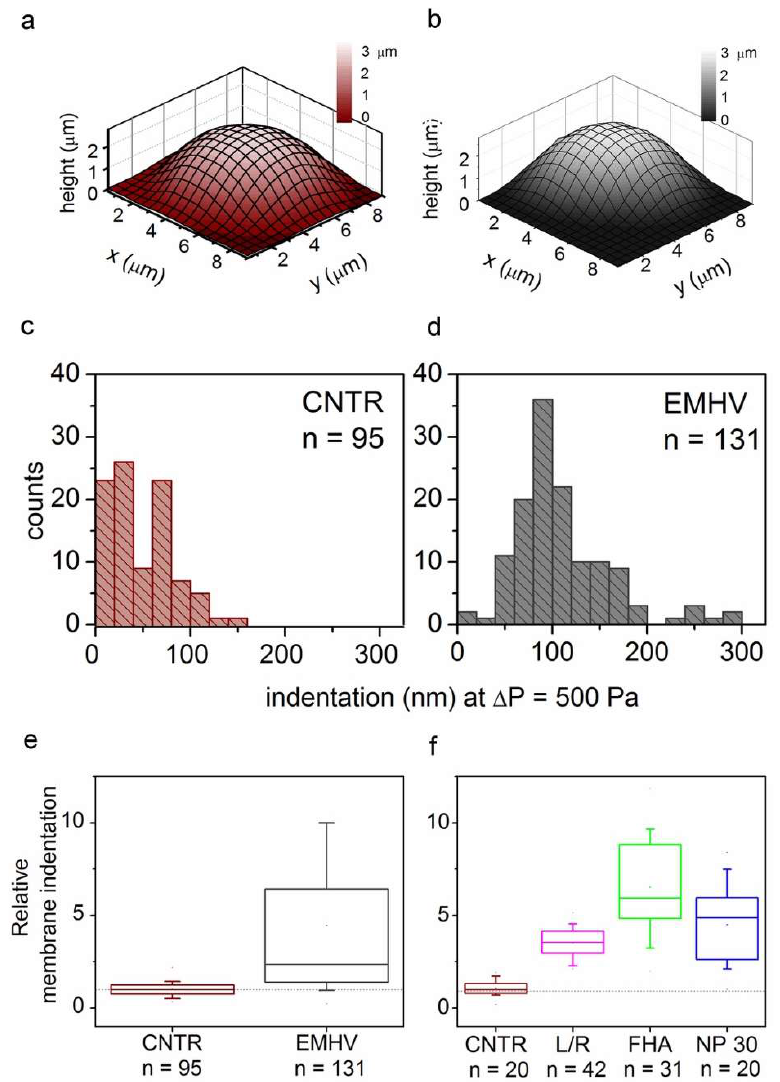
Figure 1. ( a , b ) Representative SICM maps of an RBC and an EMHV, respectively, adhered to a PLL-coated petri dish. Maps are obtained with no pressure applied to the pipette, in back step mode, with stopping criterion at 98.5%. Lateral step: 500 nm; ( c , d ) Distribution of membrane indentation values in the population of controls (normal RBCs, CNTR, n = 95) and EMHVs (n = 131). Median values are 35 nm and 97 nm, respectively; ( e ) Distribution of relative membrane indentation values (normalized over the median of normal RBCs of the same donor). CNTR as in ( c ) and EMHV as in ( d ). Whiskers show 10–90 percentile range; min, max and mean values are also shown; ( f ) Distribution of relative membrane indentation values (normalized over the median of normal RBCs of the same donor) after the different treatments used to obtain the EMHVs. CNTR: normal RBCs; L/R: lysed and resealed; FHA: lysed and resealed with only hemagglutinin inserted on membrane of erythrocytes; NP30: lysed and resealed with only 30 nm nanoparticles inside the erythrocytes. Whiskers show 10–90 percentile range; min, max and mean values are also shown.